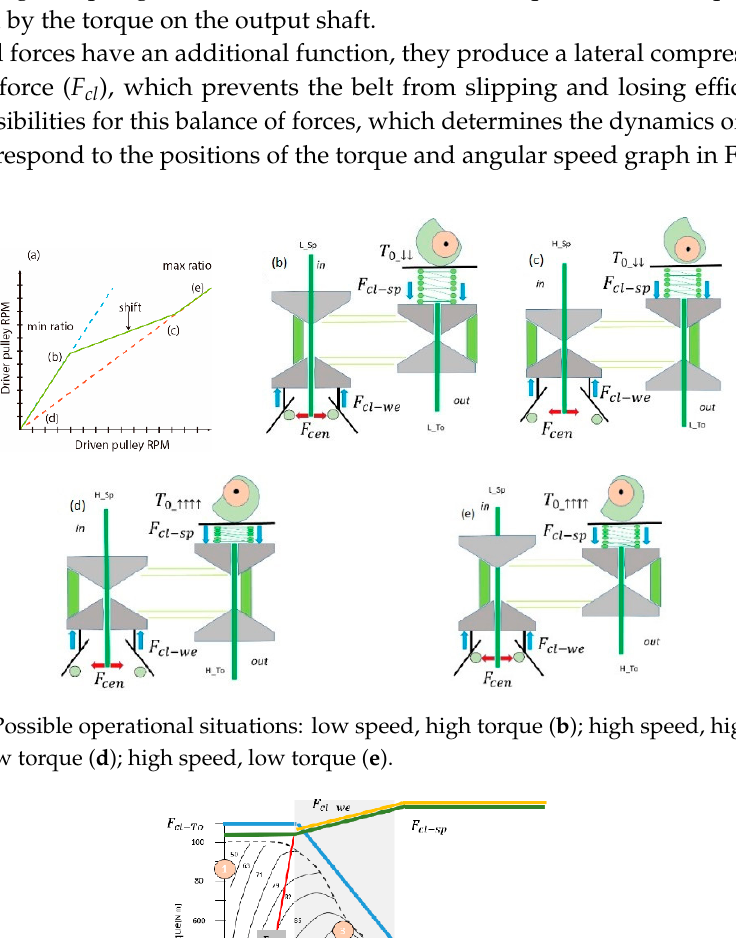
Figure 8. The clamping force (blue), the centrifugal force (red), the centrifugal force’s lateral component (yellow) and the spring force (green) are drawn over the torque and angular speed motor.